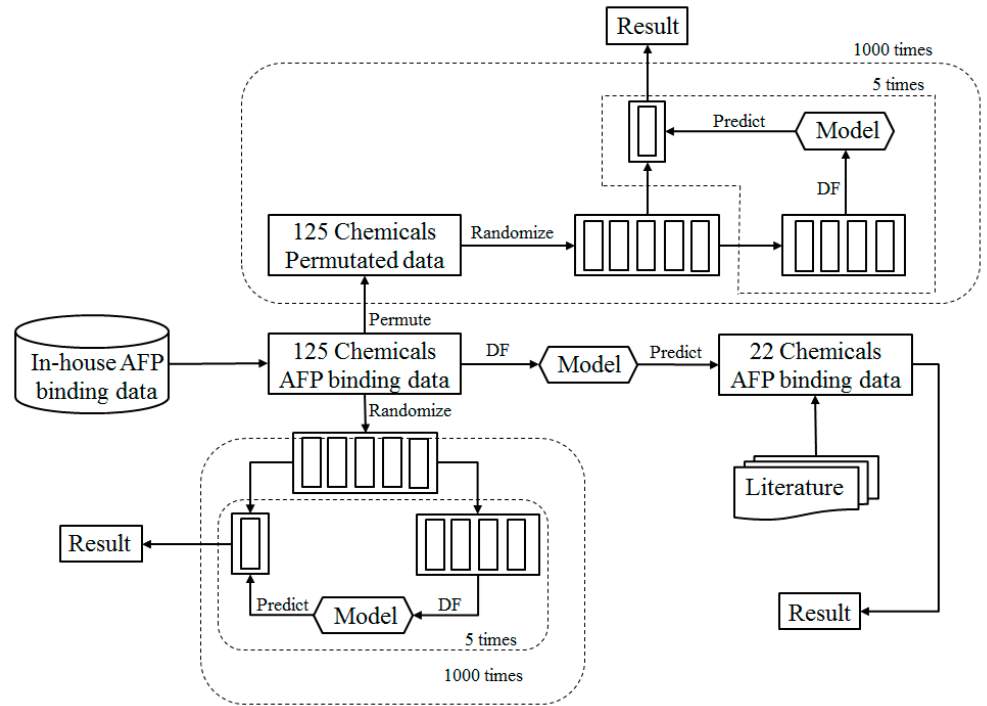
Figure 1. Overview of the study design.